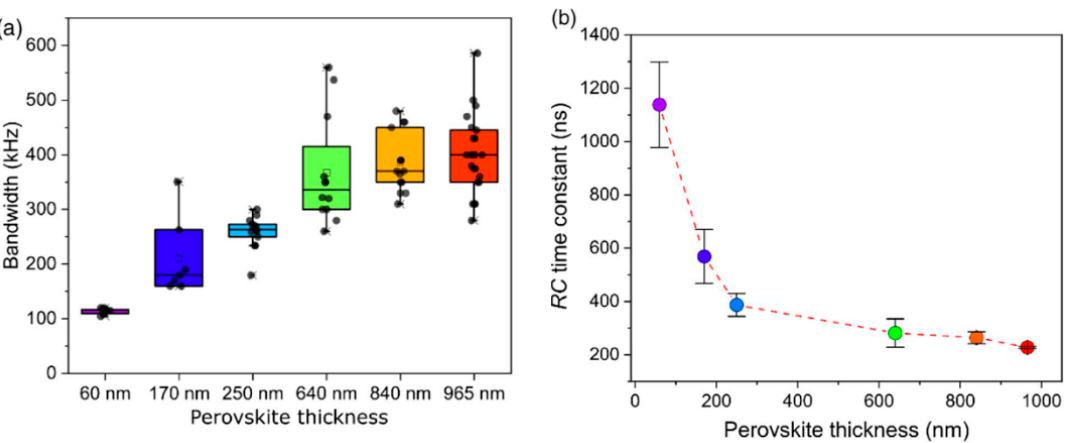
Figure 6. ( a ) Obtained bandwidth in function of perovskite thickness; ( b ) Measured RC constant for solar cells with different perovskite thickness. Reproduced with permission from [107].